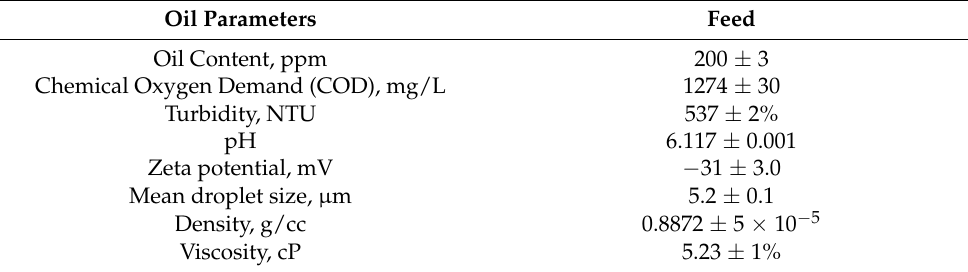
Table 2. Average feed characteristics.